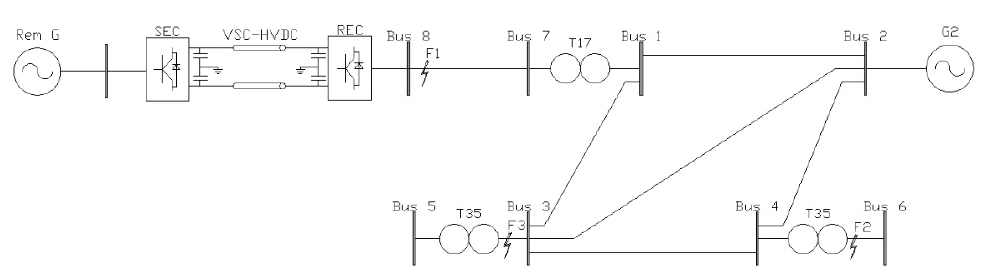
Figure 2. EPRI 9-bus test case with a VSC-HVDC connection at bus 8.